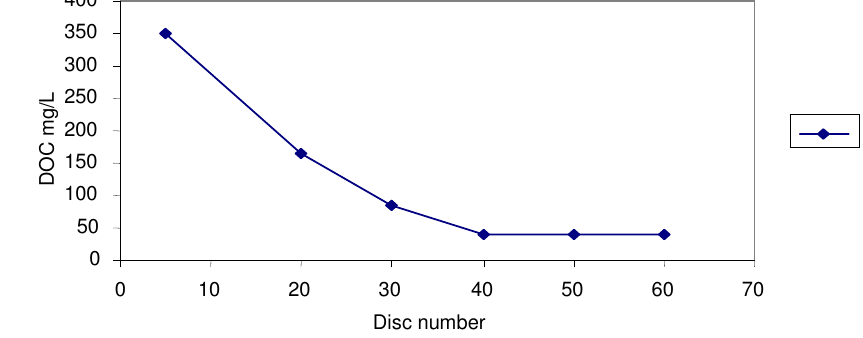
Figure 3. DOC elimination -aerobic